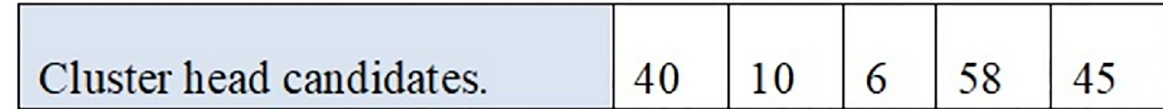
Fig 2. An example of a solution in the proposed